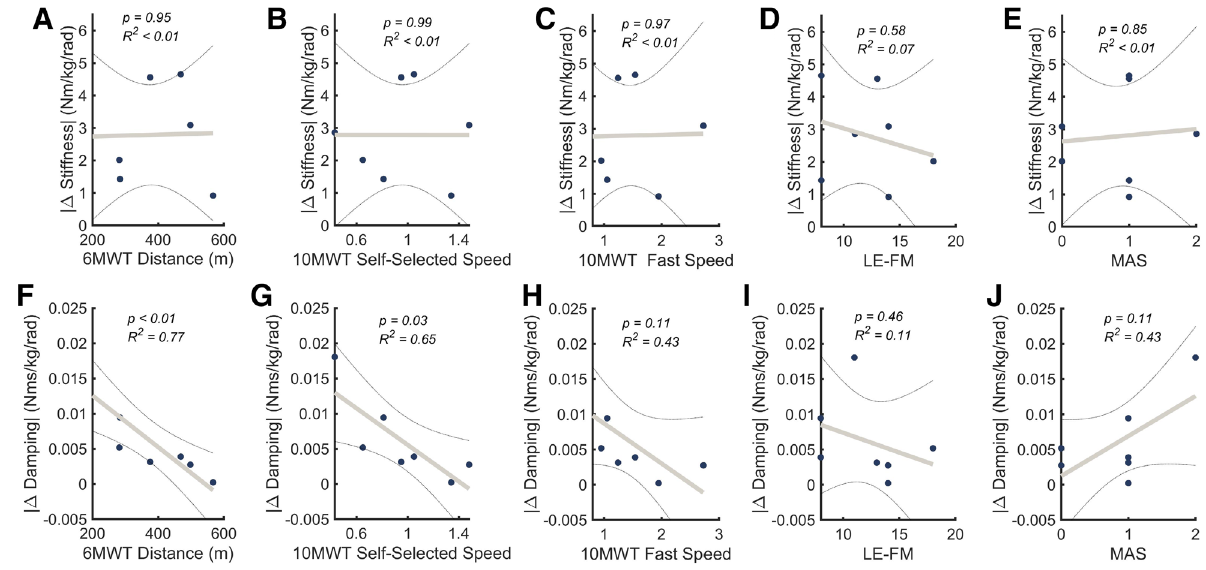
Figure 4. Stiffness ( A – E ) and damping ( F – J ) asymmetry linearly regressed across four clinical measures. Six Minute Walk Test distance was significantly correlated with the difference in damping between the paretic and non-paretic limbs ( F ), but did not relate to stiffness asymmetry ( A ). Ten Meter Walk Test speed was significantly correlated with damping asymmetry at the self-selected speed ( G ) but not the fast speed ( H ). Stiffness asymetry did not correlate with either 10MWT ( B , C ). Lower extremity Fugl–Meyer motor score did not significantly correlated with either ankle stiffness asymmetry ( D ) or damping asymmetry ( I ). Similarly, modified Ashworth score did not significantly correlate with either damping ( J ) or stiffness ( E )